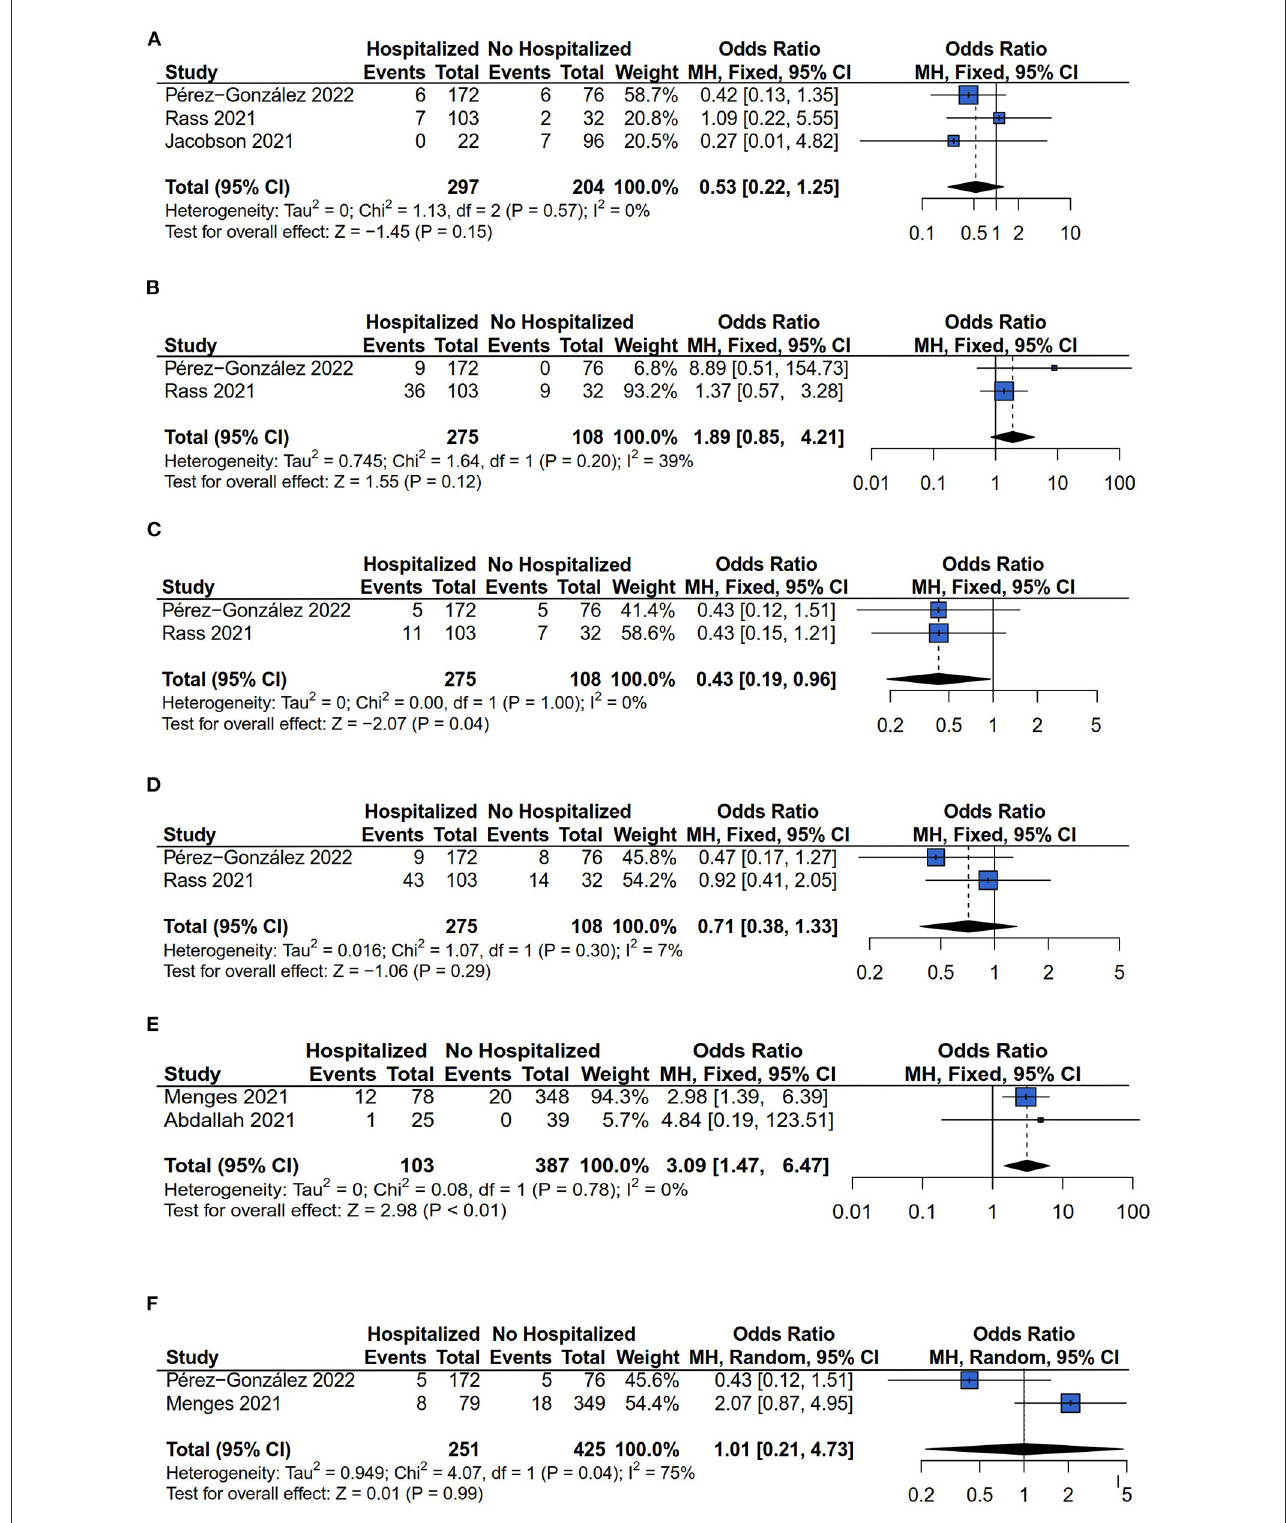
FIGURE5 Forest plot for meta-analysis of neurological symptoms risk among Hospitalized vs. non-hospitalized COVID-19 survivors. (A) Headache risk; (B) Sleep disorder risk; (C) Ageusia risk; (D) Anosmia risk; (E) Anxiety risk; (F) Depression risk.